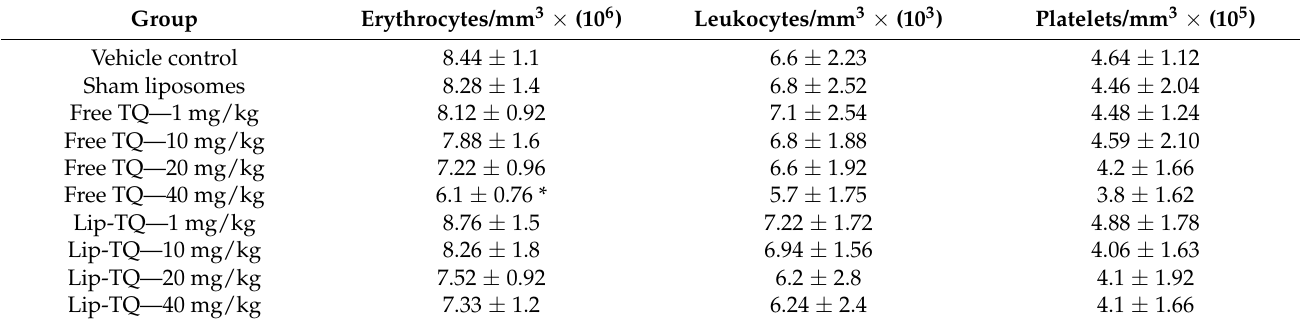
Table 2. Hematological parameters of the mice injected with various doses of free TQ or Lip-TQ.